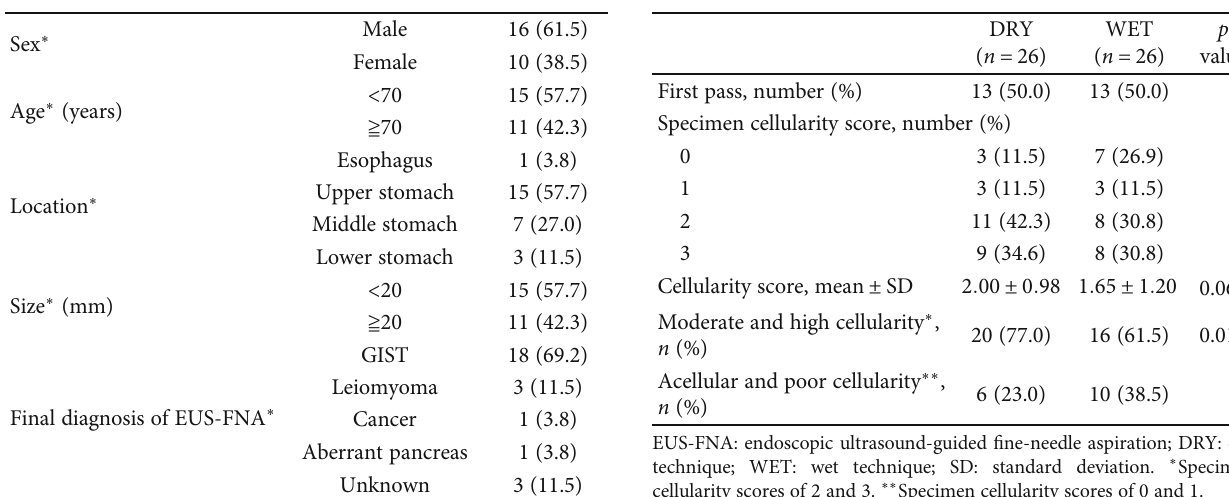
Figure 3: Measurement of cellularity area in the cell-block specimens. The specimens which were obtained by two punctures of each technique were combined into one. The area was then measured at the point of the maximum cross section using a soft imaging microscope. Table 1: Patient characteristics ( n = 26 ). Table 2: Quantity of cellularity in the EUS-FNA specimens.